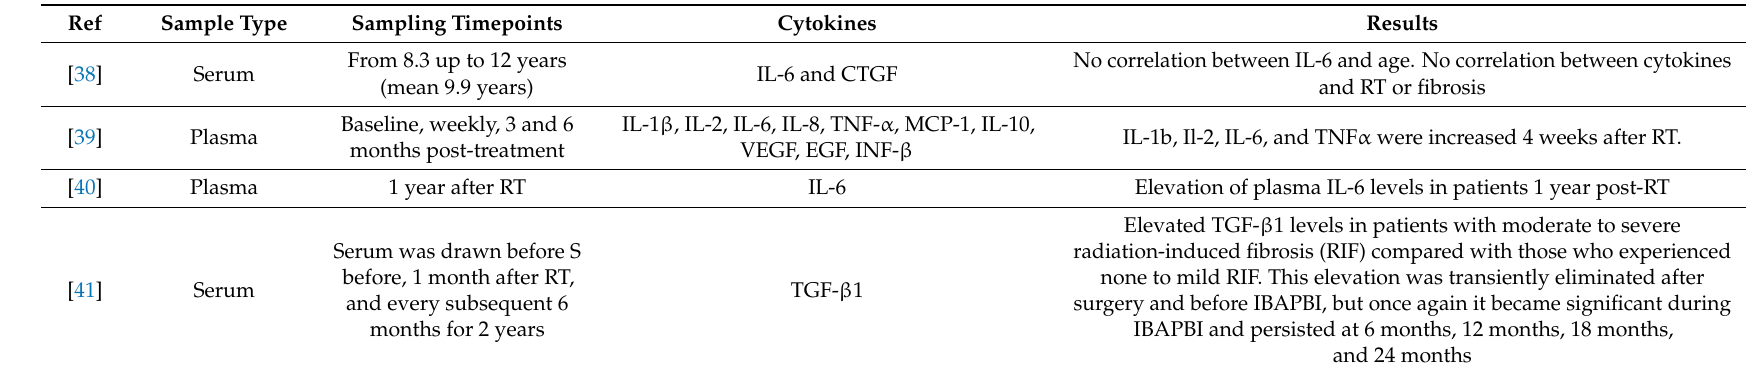
Main abbreviations for Table 2: breast cancer (BC); chemokine ligands (CCL); connective tissue growth factor (CTGF); healthy control (CTR); chemokine (C-X-C motif) ligand (CXC); intracavitary brachytherapy accelerated partial breast irradiation (IBAPBI); interleukin (IL); interferon (INF); intraoperative radiotherapy (IORT), lipopolysaccharide (LPS);